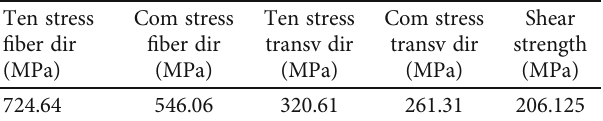
Table 3: T300/epoxy composite properties [9, 10].